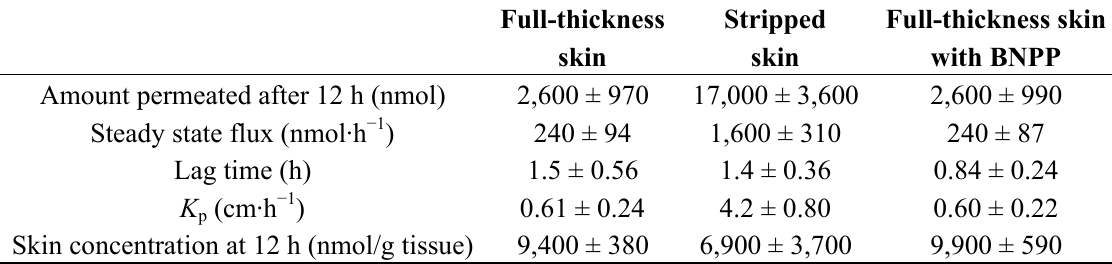
Table 3. Pharmacokinetic parameters for permeation of PL across rat